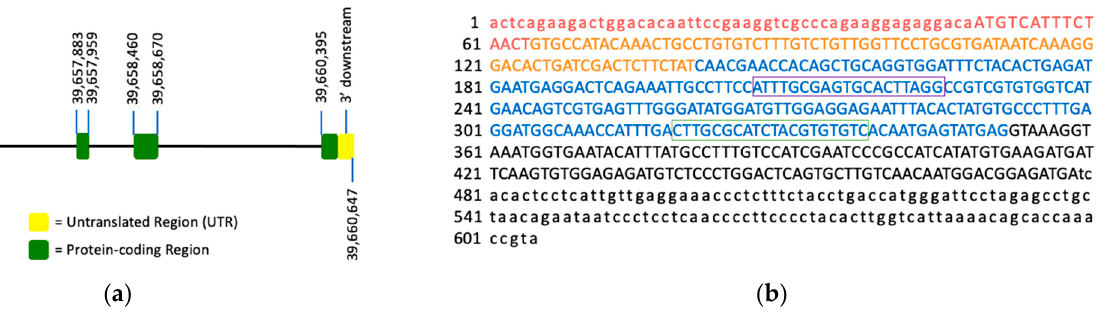
Figure 1. LGALS16 gene structure and the mRNA sequence. ( a ) LGALS16 (4735 bp) is located on chromosomal band 19q13.2 and contains 4 exons (ENSG00000249861). ( b ) NCBI reference sequence of LGASL16 mRNA (NM_001190441.3). Each exon is highlighted with red, orange, blue, and black representing exons 1, 2, 3, and 4, respectively. The protein coding sequence (CDS) is indicated in capitals while UTRs in small characters. The oligonucleotide sequences for PCR amplification are boxed.